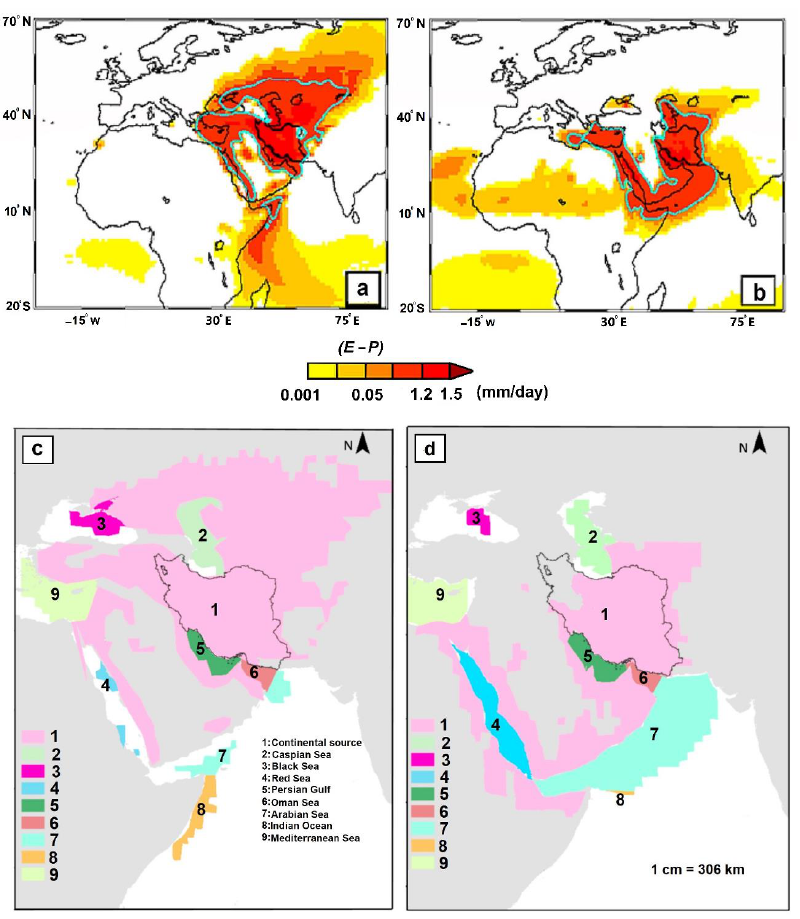
Figure 4. Variation in ( E − P ) > 0 (mm/day) in dry ( a ) and wet ( b ) periods [7,11] (E, evaporation; P, precipitation). The spatial distribution of moisture sources for Iran during the dry ( c ) and wet ( d ) periods.